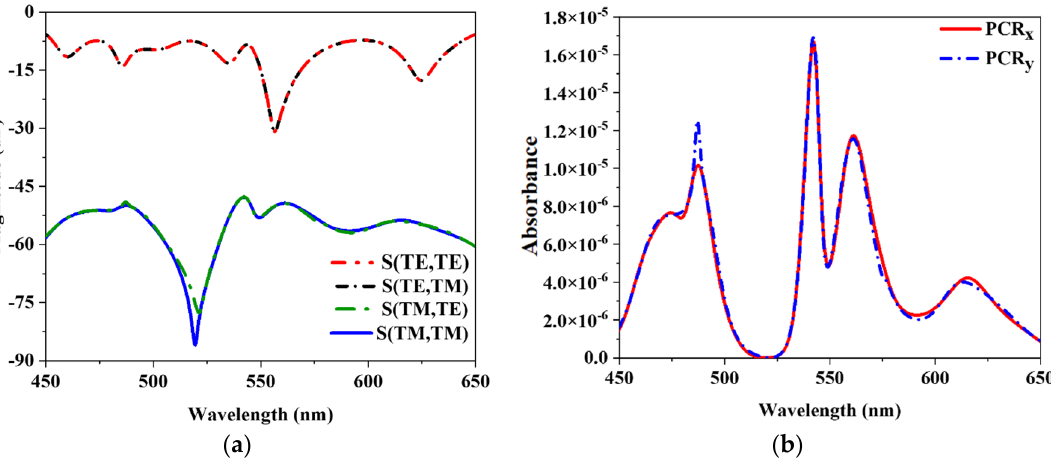
Figure 9. ( a ) Co-polar and Cross-polar component ( b ) The PCR value of x-polar and y-polar of the incident wave.